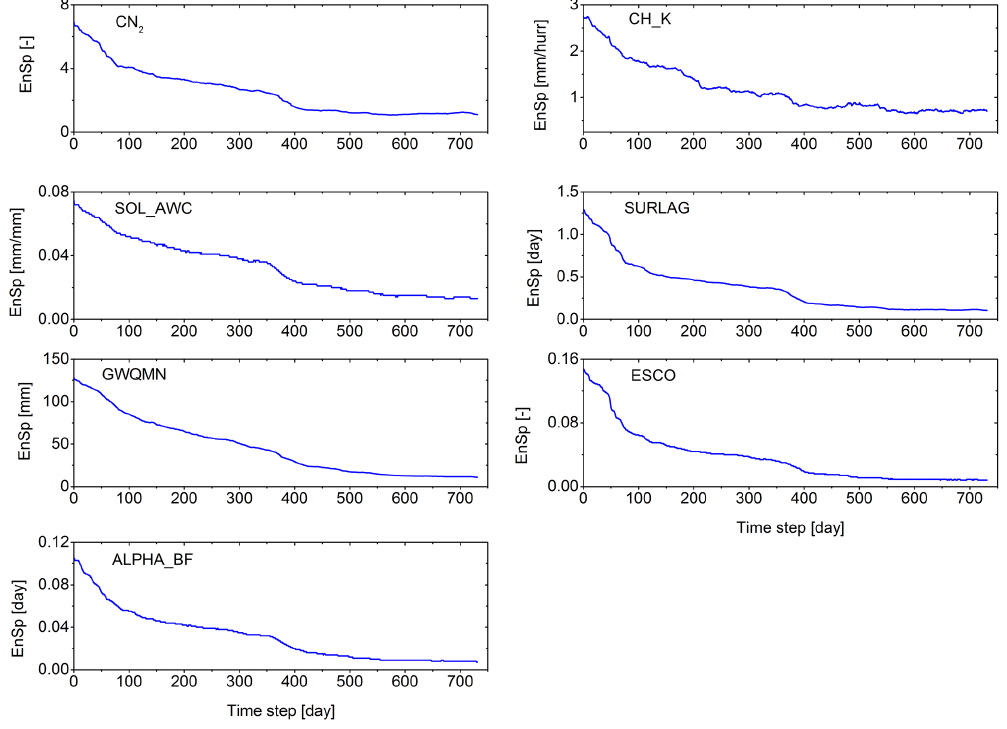
q P Nu 1 VAR En (i) , where “Nu” is the number of Nu i = 1